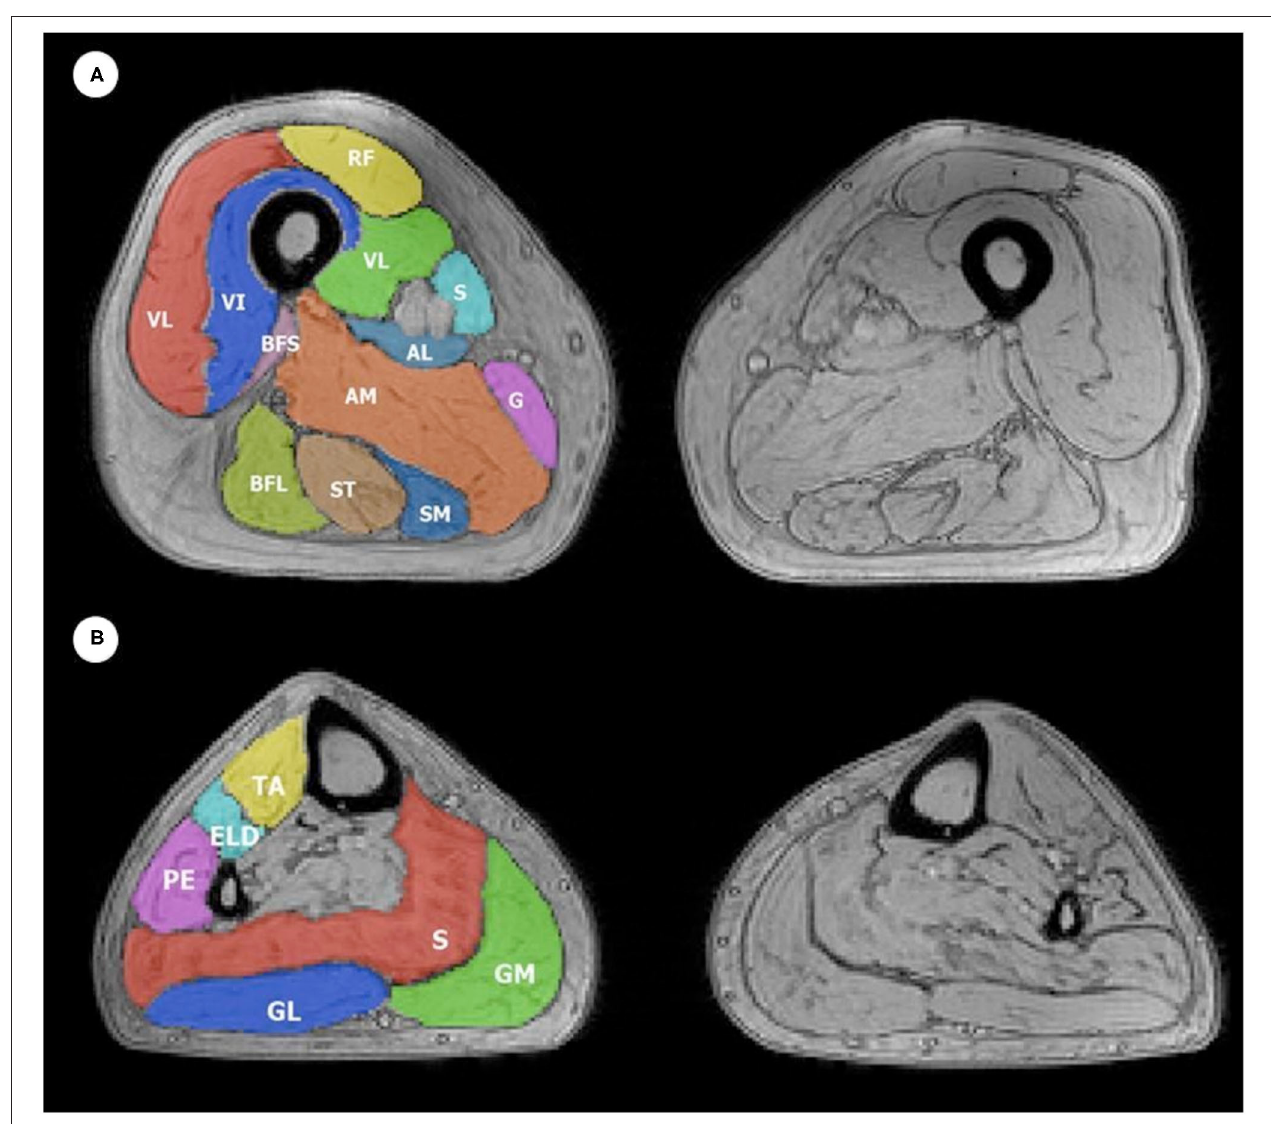
FIGURE 1 | Example of ROIs obtained during manual (A) thigh and (B) leg muscle segmentation superimposed on a T2w GRE image. The color code indicates all 12 thigh ROIs and six leg ROIs that were considered, which were drawn on both the left and right thigh, with the corresponding muscle indicated in the figure with its respective initials, as follows: (A) Thigh muscles: VL, vastus lateralis; VM, vastus medialis; VI, vastus intermedius; RF, rectus femoris; Sa, sartorius; G, gracilis; AM, adductor magnus; SM, semimembranosus; ST, semitendinosus; BFL, long head of biceps femoris; BFS, short head of biceps femoris; AL, adductor longus.